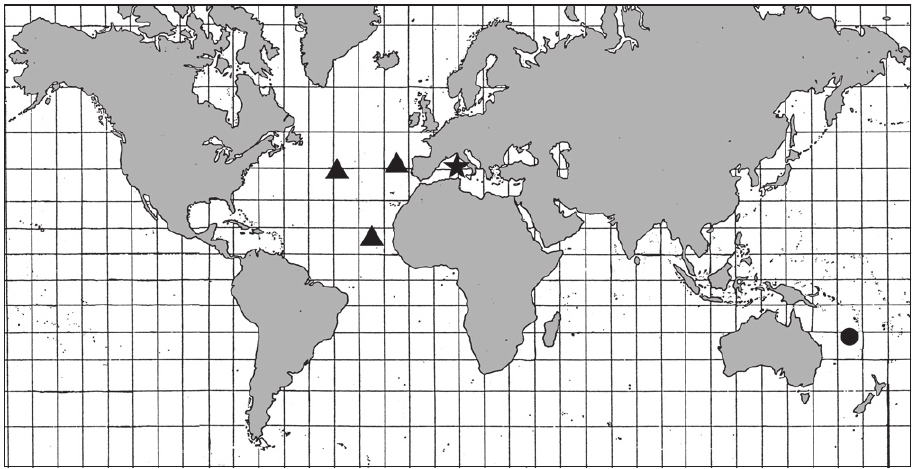
Fig. 4. Geographic range of the genus Neophrissospongia with occurrences of the known species N. noli- tangere in the Atlantic and N. microstylifer in the Pacifi c Ocean. Th e type locality of N. nana nov. sp. from Sardinia is indicated by a